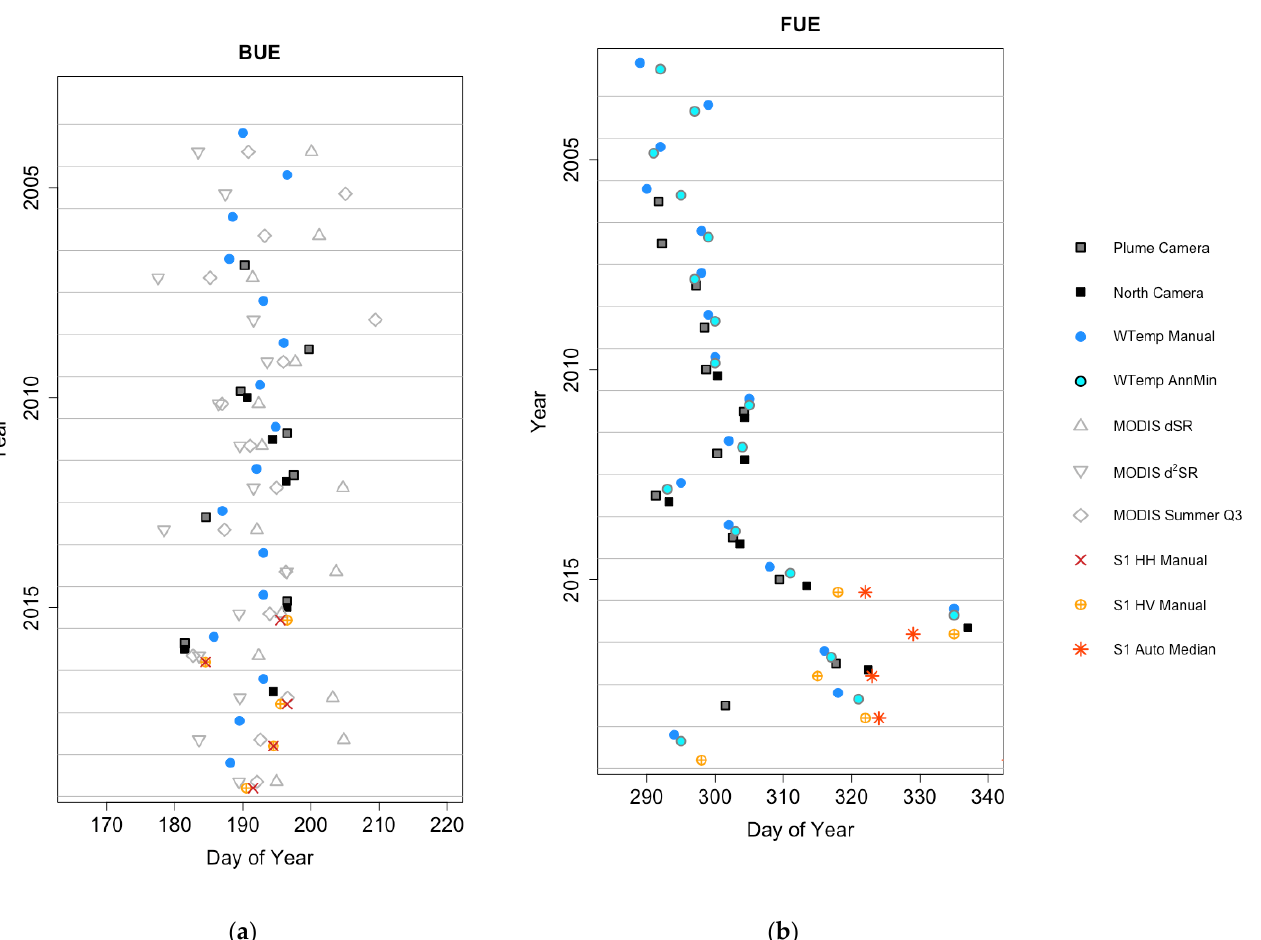
Figure 8. ( a ) Timing of BUE (x-axis) from the various in-situ and remote sensing methods in this analysis for each year in the study period (y-axis). ( b ) Same as ( a ), but for FUE. The dark, square markers indicate dates estimated from camera images, blue circular markers are estimates from water temperature dynamics, light gray markers are estimates from MODIS, and orange and red markers are estimates from Sentinel-1. The symbols are slightly offset on the vertical axis to reduce overlap. A trend toward later FUE is visible in ( b ), while no BUE trend is observed in ( a ).